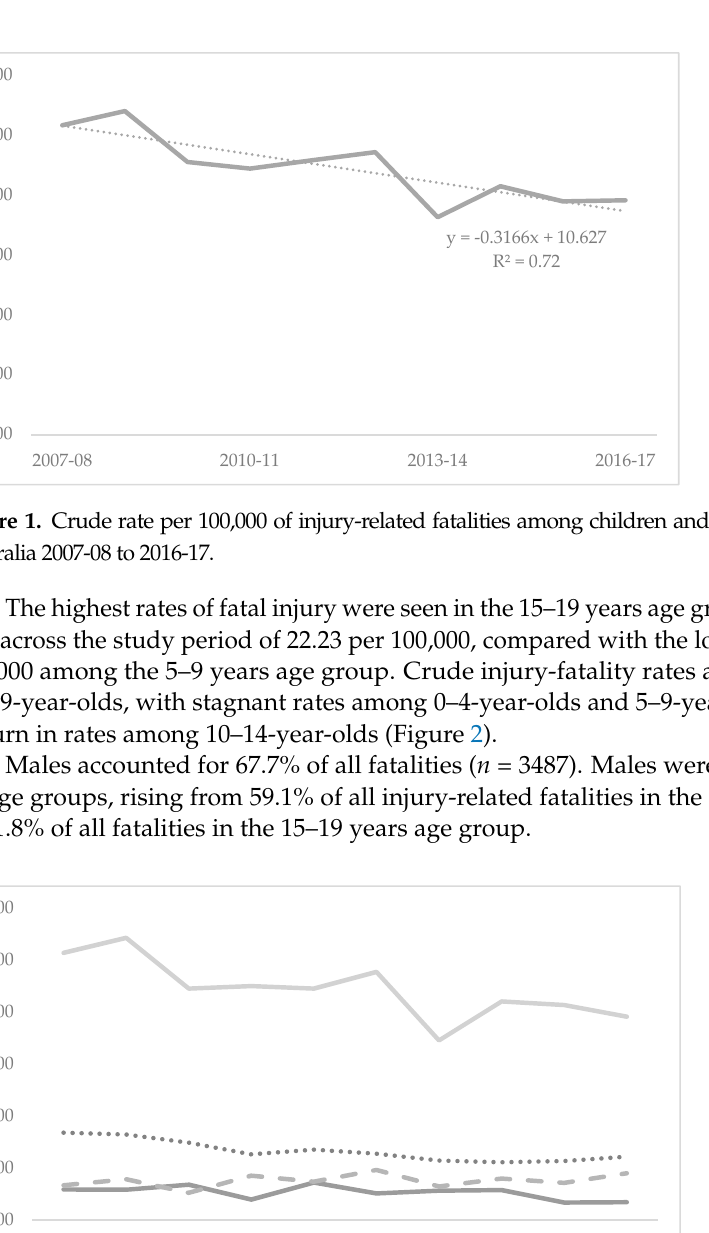
Figure 2. Crude rate per 100,000 of injury-related fatalities among children and adolescents 0–19 years, Australia 2007-08 to 2016-17.